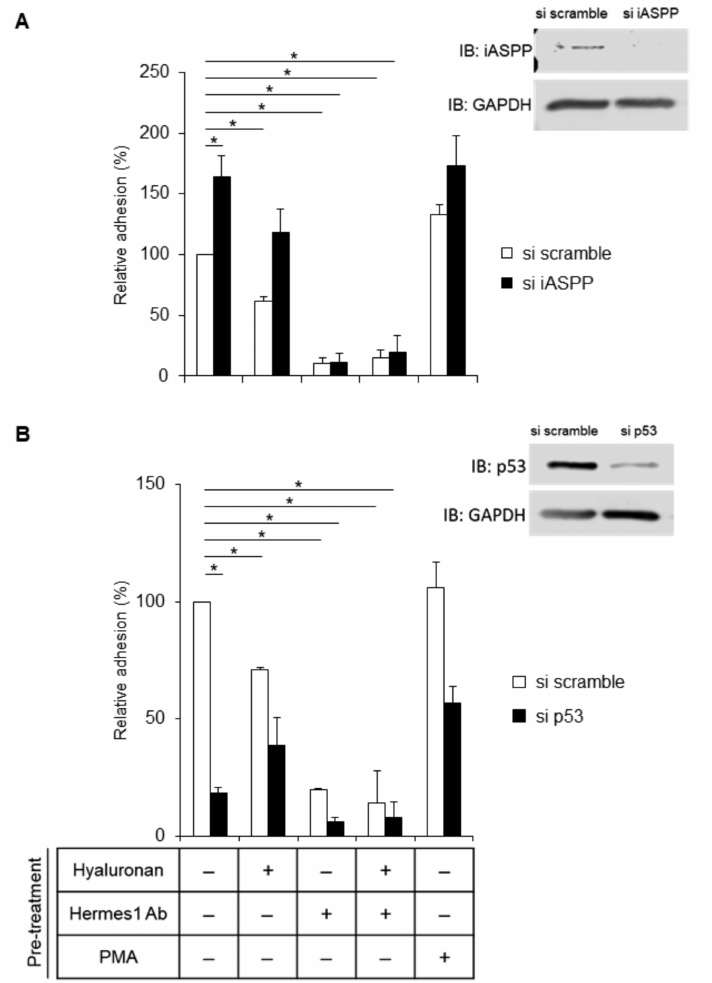
Figure 8. iASPP suppresses but p53 increases CD44-mediated adhesion of fibroblasts. ( A , B ) AG1523 fibroblasts incubated with iASPP siRNA ( A ), p53 siRNA ( B ), or scramble siRNA, were pre-treated, or not, with hyaluronan and blocking CD44 antibody or PMA and then seeded (30,000 cells per well) and incubated for 30 min. Adhered cells were then visualized by staining with crystal violet and quantified by measurement of the absorbance at 570 nm. The data are plotted in bar graphs representing the mean ± SD of at least three independent experiments (* p < 0.05, Student’s t -test). The uncropped blots are shown in File